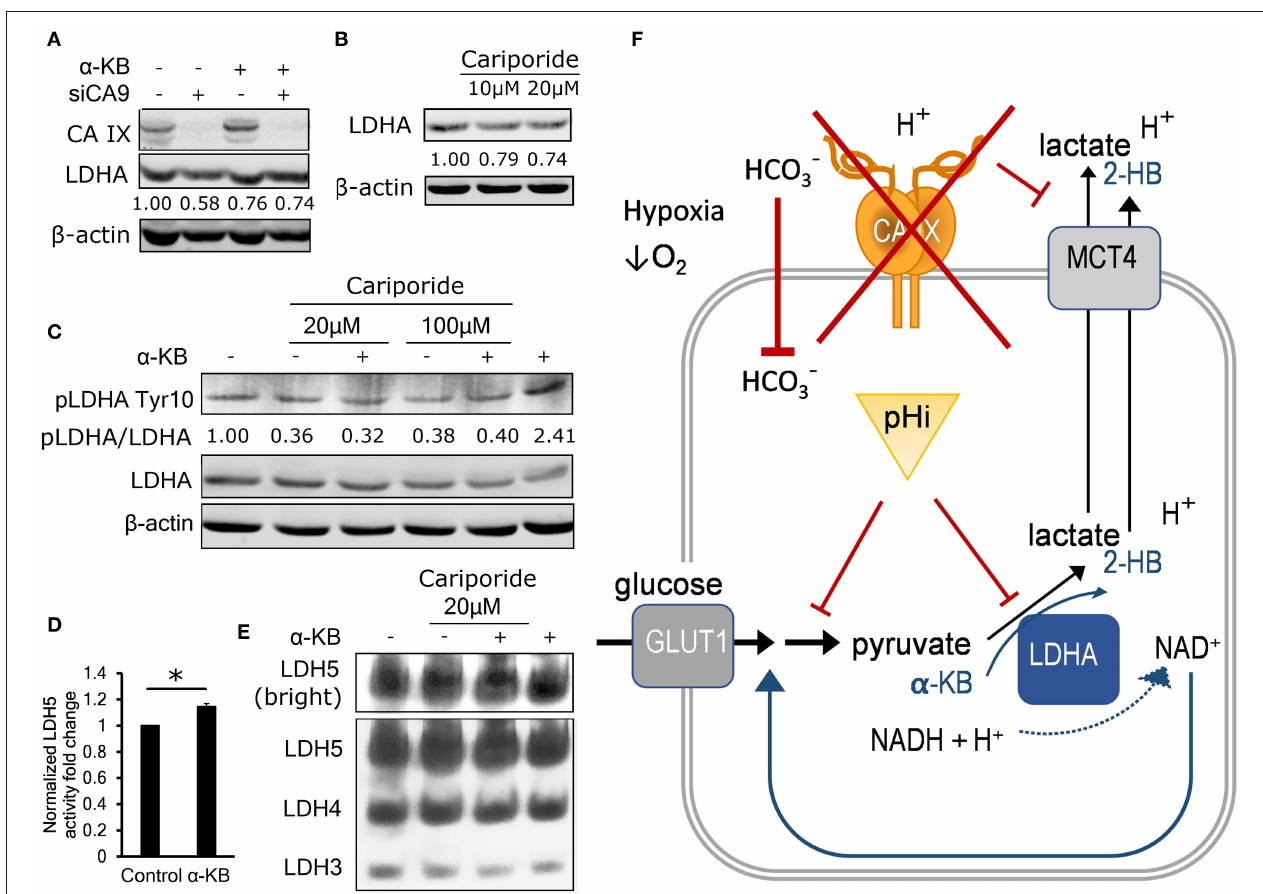
FIGURE 4 | Intracellular acidosis decreases LDHA level and activity. (A) Representative immunoblot ( n = 3) showing LDHA levels in control and α -KB-treated A-549 KD cells incubated for 48h in 1% O 2 , numbers represent relative LDHA levels quantified against β -actin in the presented blot. (B) Representative immunoblot ( n = 3) showing the effect of sodium-hydrogen antiporter 1 (NHE-1) inhibition by cariporide on LDHA levels in normoxic parental HT-1080 cells, numbers represent relative LDHA levels quantified against β -actin in the presented blot. (C) Representative immunoblot ( n = 3) showing the effect of 48h cariporide and α -KB treatment on the levels of activating LDHA tyrosine 10 phosphorylation (pLDHA Tyr10) in normoxic HT-1080 cells, numbers represent pTyr10/LDHA ratio in the presented blot. (D) LDH5 activity of normoxic HT-1080 cells in response to α -KB ( n = 3). (E) Representative LDH activity assay showing LDH5 in the enhanced contrast field (bright, top) and resolved LDH5-LDH3 isoforms (bottom) in response to α -KB and 20 µ M cariporide. (F) Schematic indicating the interaction between CAIX, pHi, and the regulation of glycolysis and lactate production. Error bars are ± SEM. P -values were calculated against Control by t -test. * P < 0.05; ** P < 0.01 *** P <